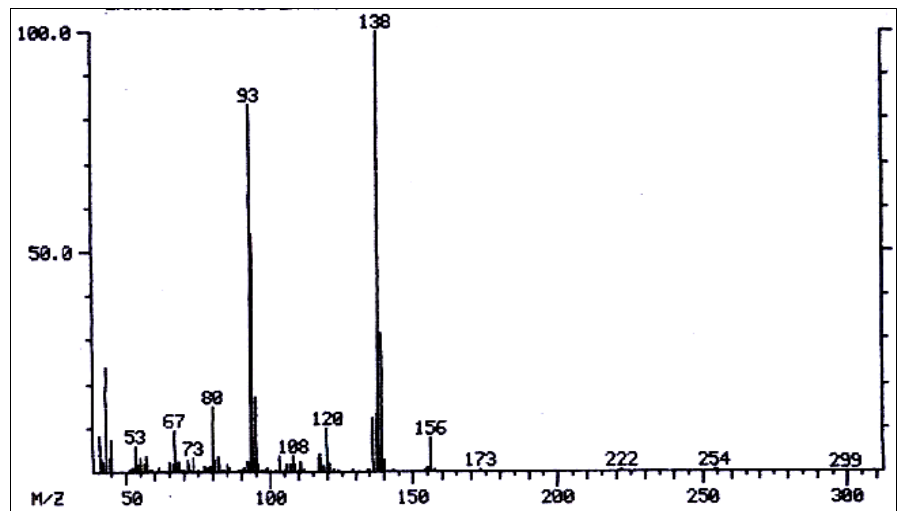
Figure 11. Mass spectrum of